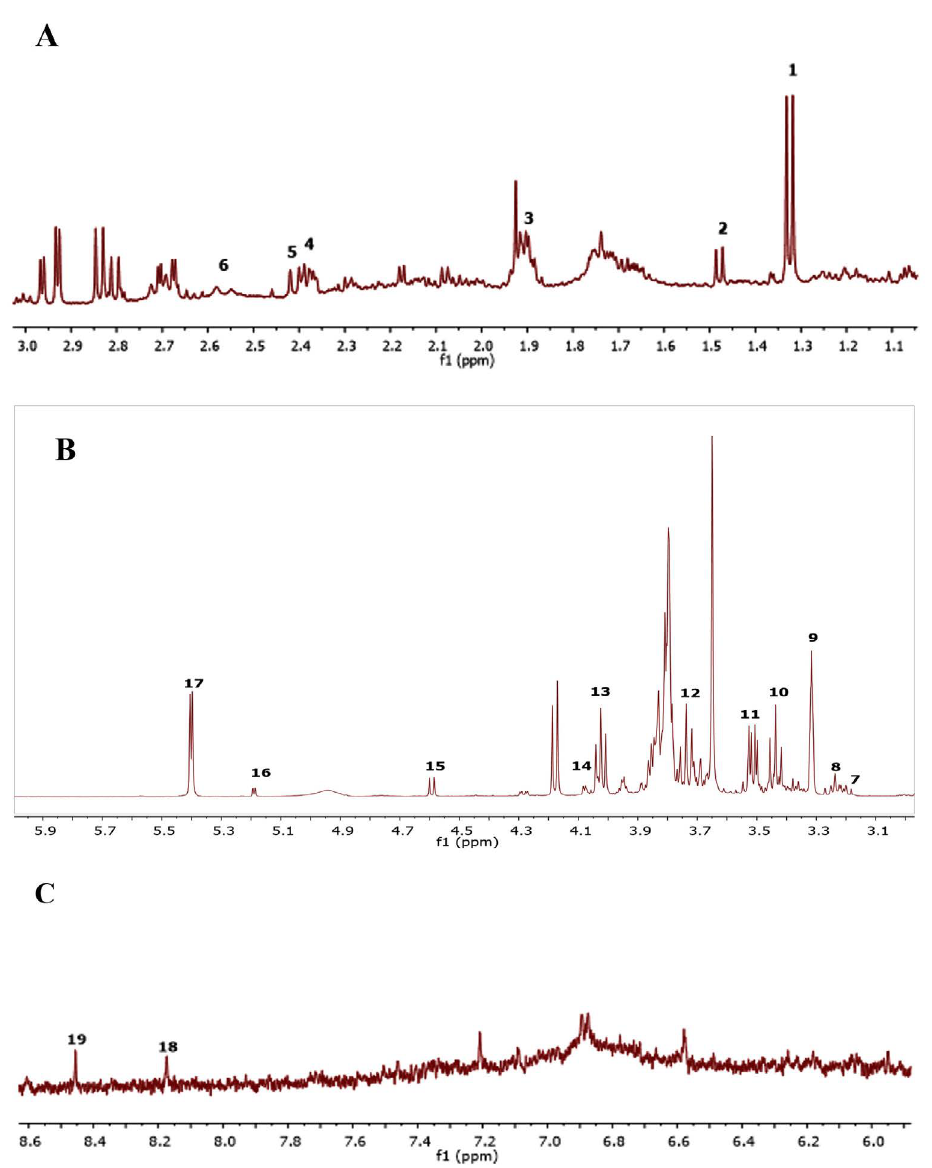
Fig. 4. 1 H-NMR spectra of the fermented Cyperus rotundus extract. (A) Spectra of δ 1.0 to 3.0 ppm. (B) Spectra of δ 3.0 to 6.0 ppm. (C) Spectra of δ 6.0 to 8.0 ppm Identified 1 H-NMR signals; (1) Lactic acid, (2) Alanine, (3) Acetic acid, (4) Succinic acid, (5) Pyruvic acid, (6) citric acid, (7) Choline, (8) Beta Glucose, (9) Betaine, (10) Acetoacetate, (11) Caffeine, (12) Lysine, (13) Ascorbic acid, (14) Fructose, (15) Xylose, (16) Alpha Glucose, (17) Sucrose, (18) Anserine and (19) Fumaric